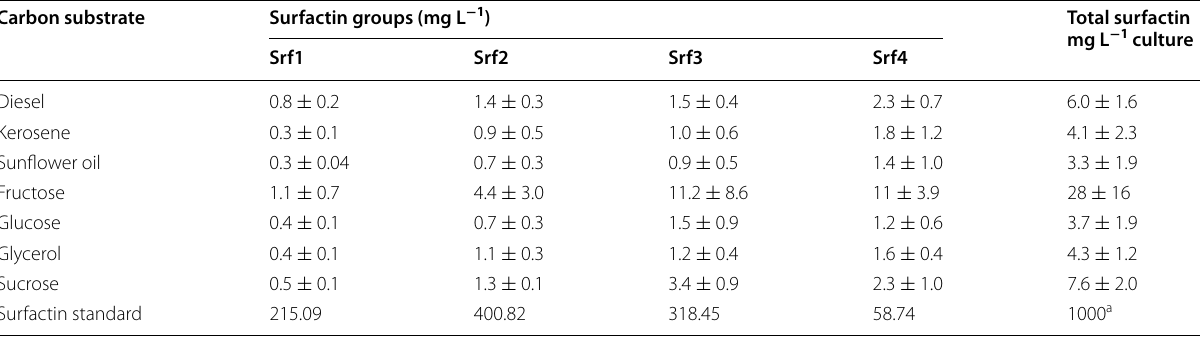
Table 2 Comparison of the approximate quantities of each surfactin group and the total surfactin production pro- file by B. amyloliquefaciens ST34 grown in mineral salt medium supplemented with different substrates as sole carbon